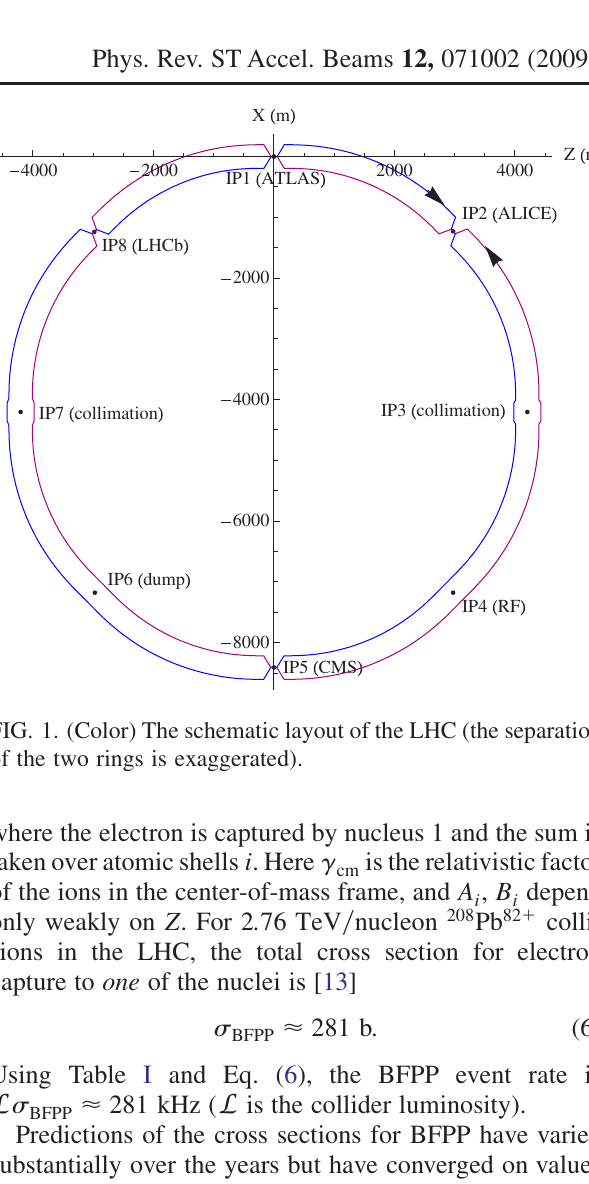
Using Table I and Eq. (6), the BFPP event rate is L (cid:1) (cid:2) 281 kHz ( L is the collider luminosity). BFPP